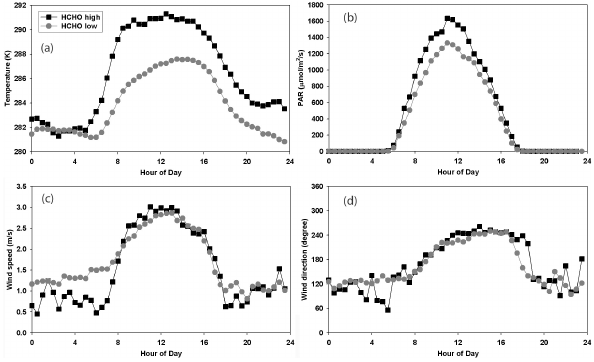
Fig. 6. Mean diurnal profiles of (a) temperature (K), (b) PAR (µmolm − 2 s − 1 ) , (c) wind speed (ms − 1 ) , and (d) wind direction (0 ◦ to North) during HCHO High (dark squares; 259 ∼ 261 and 264) and Low phases (gray circles; 262 ∼ 263 and 265 ∼ 277) of BEARPEX 2007.